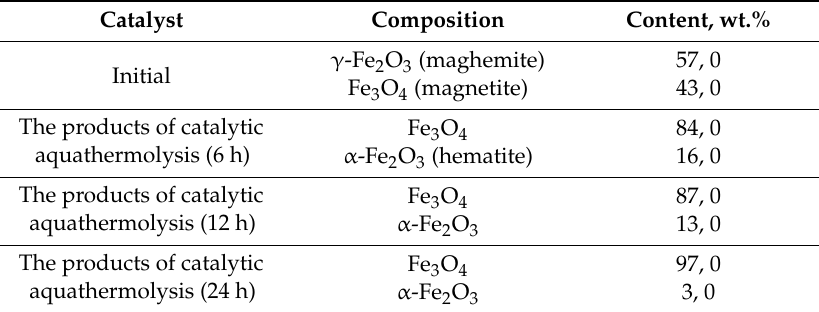
Table 1. The composition of obtained metallic oxides at 250 ◦